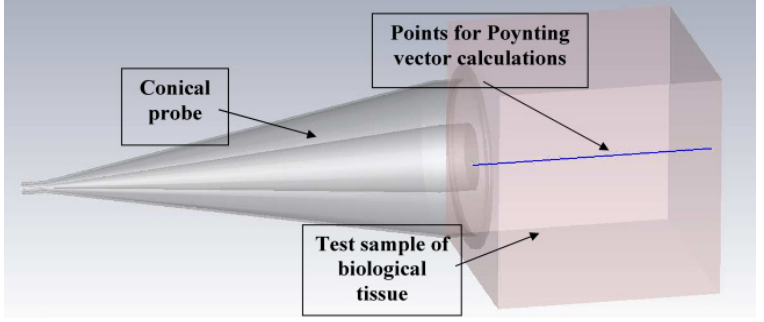
Figure 2. Scheme of simulation of the probe radiation interaction with phantoms of biological tis- sues.